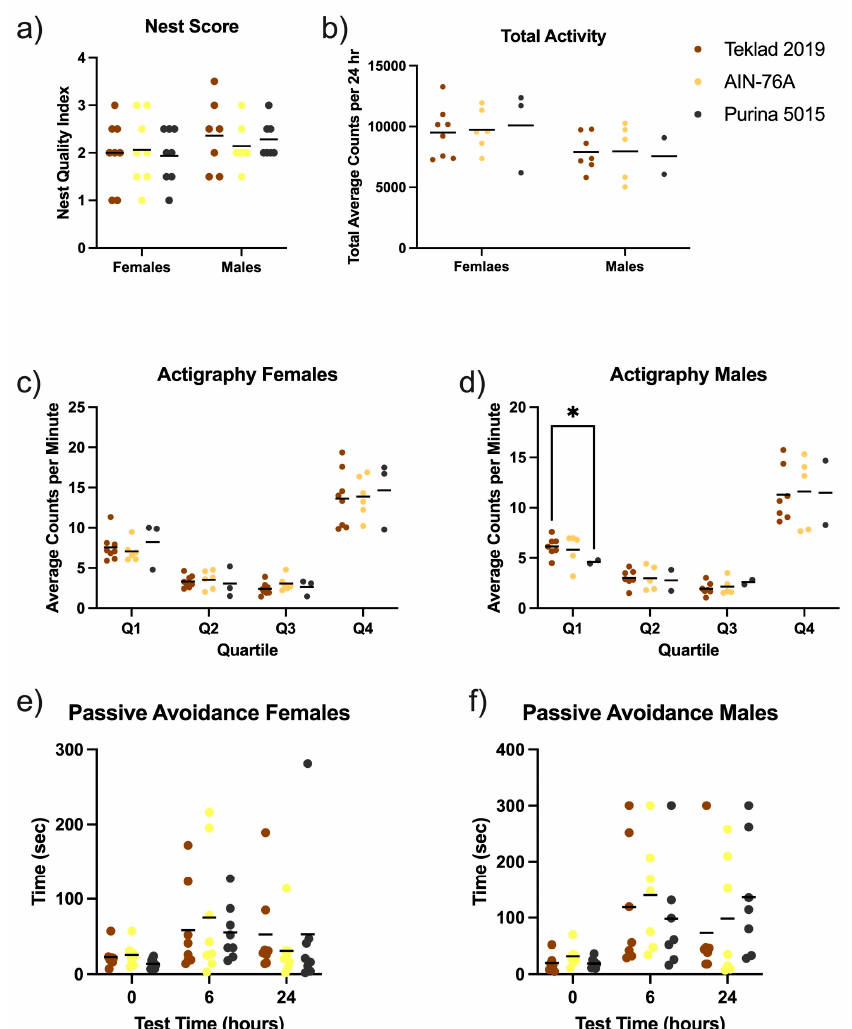
Figure 4. Mouse behavior as an effect of diet. Male and female C57BL/6J mice were tested in a behavioral battery including nest building, actigraphy and passive avoidance in response to diet (Teklad 2019, AIN-76A or Purina 5015). Statistics were determined by 2-way ANOVA and Tukey’s multiple comparison tests denoted by p < 0.05 (*). ( a ) nest score was plotted versus diet and sex. ANOVA results: interaction F(2, 39) = 0.2389, p = 0.79; sex F(1, 39) = 1.987, p = 0.17; and diet F(2, 39) = 0.066, p = 0.94. ( b ) total average activity counts per 24 h period plotted versus diet and sex. ANOVA results: interaction F(2, 25) = 0.089, p = 0.92; sex F(1, 25) = 5.436, p = 0.0281; and diet F(2, 25) = 0.017, p = 0.98. ( c ) average actigraphy counts per minute for female mice were binned into 6 h quartiles and plotted versus diet. ANOVA results: time × diet F(6, 42) = 0.4142, p = 0.87; time F(1.451, 20.31) = 177.6, p < 0.0001; diet F(2, 14) = 0.07965, p = 0.9239; and subject F(14, 42) = 4.362, p = 0.0001. ( d ) average actigraphy counts per minute for male mice were binned into 6 h quartiles and plotted versus diet. ANOVA results: time x diet F(6, 33) = 0.3313, p = 0.92; time F(1.270, 13.97) = 89.13, p < 0.0001; diet F(2, 11) = 0.03130, p = 0.9693; and subject F(11, 33) = 3.551, p = 0.0023. ( e ) passive avoidance times to enter the dark chamber for female mice were plotted versus diet. ANOVA results: time x diet F(4, 42) = 0.5027, p = 0.74; time F(1.707, 35.85) = 4.537, p = 0.0221; diet F(2, 21) = 0.02663, p = 0.97; and subject F(21, 42) = 1.619, p = 0.0909. ( f ) passive avoidance times to enter the dark chamber for male mice were plotted versus diet. ANOVA results: time x diet F(4, 36) = 0.8736, p = 0.49; time F(1.886, 33.94) = 11.31, p = 0.0002; diet F(2, 18) = 0.1725, p = 0.84; and subject F(18, 36) = 2.513, p = 0.0091.